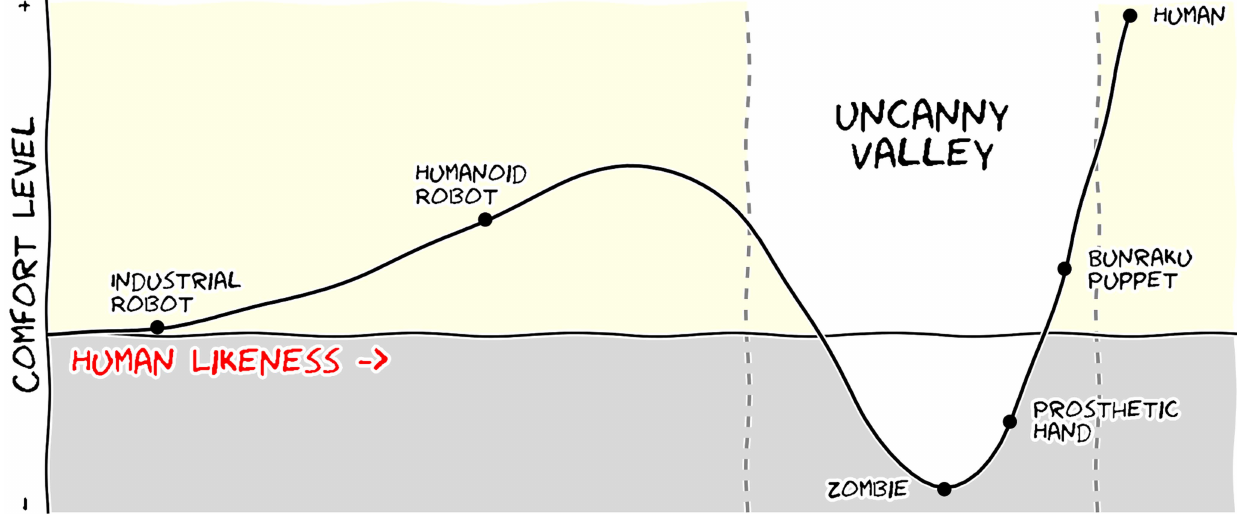
Figure 8. Message trumps beauty. This figure is an extreme case where the message is particularly clear even if the aesthetic of the figure is questionable. The uncanny valley is a well-known hypothesis in the field of robotics that correlates our comfort level with the human-likeness of a robot. To express this hypothetical nature, hypothetical data were used ( y ~ x 2 { 5 e { 5( x { 2) 2 ) and the figure was given a sketched look (xkcd filter on matplotlib) associated with a cartoonish font that enhances the overall effect. Tick labels were also removed since only the overall shape of the curve matters. Using a sketch style conveys to the viewer that the data is approximate, and that it is the higher-level concepts rather than low-level details that are important [10].